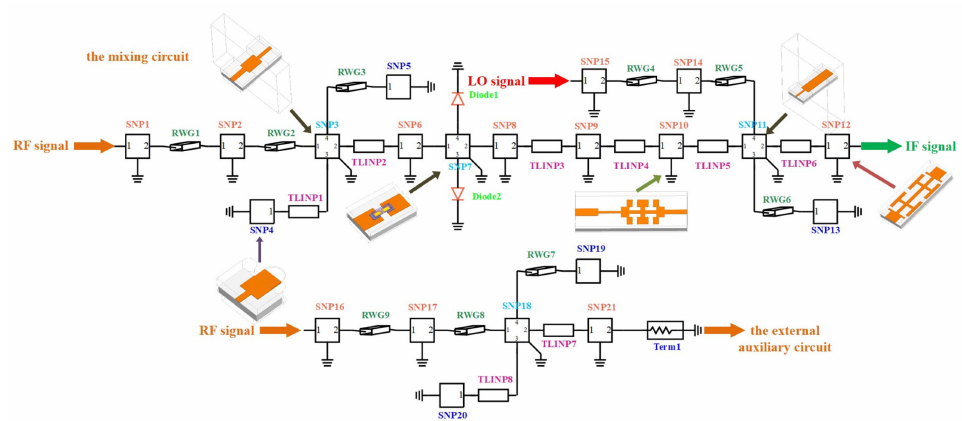
Figure 4. The improved active circuit model of 0.34 THz sub-harmonic mixer using two stage reduced matching